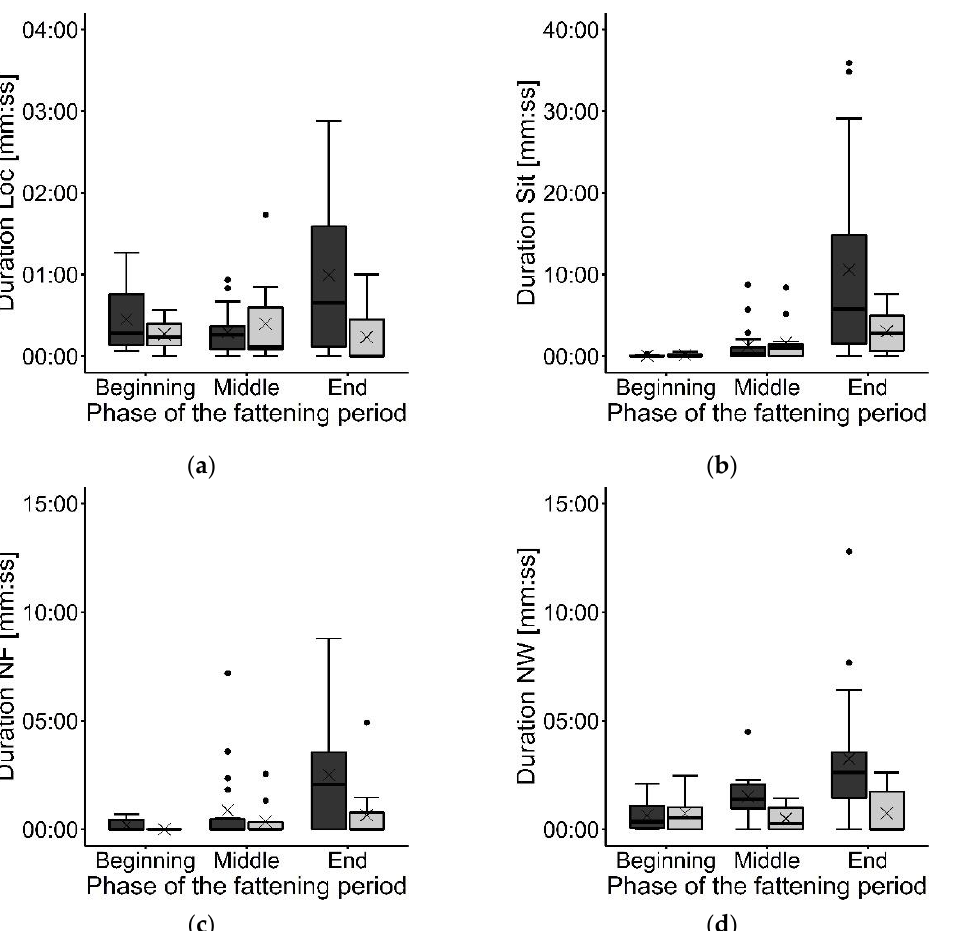
Figure 5. Duration of the different behaviors at the different phases of the fattening period: ( a ) locomotion (Loc); ( b ) sitting inactive (Sit); ( c ) located near the feeding trough (NF); and ( d ) located near the waterline (NW). Results are presented as boxplots (data range, median, and lower and upper quartile; outliers are included in the graph as dots and means as a cross). Results of the experimental group (Exp) are presented in dark gray; the control group (Con) results are presented in light gray.